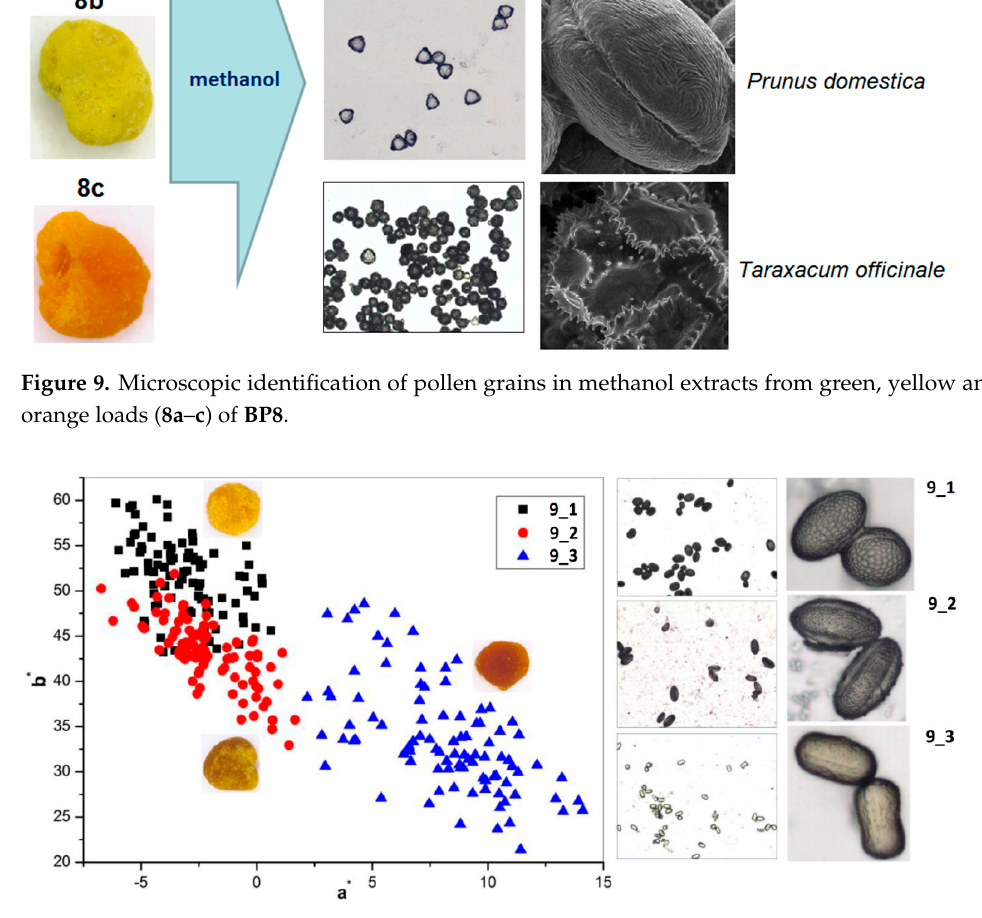
Figure 10. Chromatic diagram {a*; b*} (left) and microscopic images (right) of unifloral bee pollen loads BP9 _1, BP9 _2, and BP9 _3 ( Fagopyrum esculentum ).